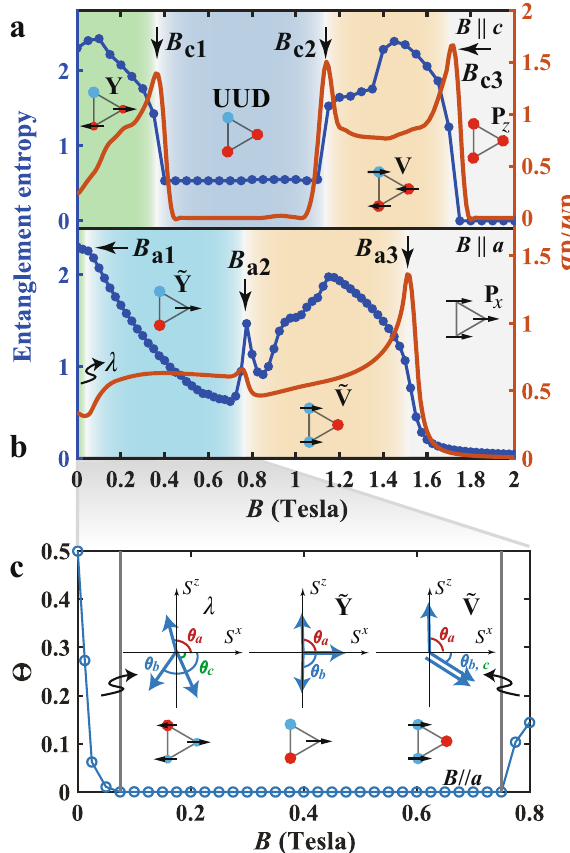
Fig. 3 Zero-temperature phase diagrams under in- and out-of- plane fi elds. a Shows the entanglement entropy and differential magnetic susceptibility dM / dB as functions of fi eld B in the c direction. The Y, UUD, V, and P z phases are shaded in different colors. B c 1, c 2, c 3 are the three critical fi elds separating these phases. The corresponding spin con fi gurations are also shown. Red (blue) circles represent the positive (negative) S z component. Black arrows show the direction of the in-plane ( S x , y ) component. b Is similar to ( a ) but for fi eld B ∥ a . The λ phase, e Y phase, ~ V phase, and P x phase are separated by three critical fi elds B a 1, a 2, a 3 . c Is a zoom-in of ( b ), showing the side view of the spin con fi gurations, as well as the evolution of the order parameter Θ as a function of the fi eld (see main text for de fi are separated by three critical fi elds B a 1 = 0.075 T, B a 2 = 0.75 T, and B a 3 = 1.51 T. The presence of a fi eld ∥ a breaks the U(1)- rotational symmetry with respect to the S z axis but preserves the π -rotational ( Z x axis. The λ phase, 2 ) symmetry with respect to the S where the spins sitting on three magnetic sublattices form the greek letter “ λ ” , spontaneously breaks both the Z 2 symmetry and the lattice translation symmetry. The Z 2 symmetry is restored in the ~ Y phase, and spontaneously broken again in the ~ V phase. Comparing to the fi eld-induced transitions in B ∥ c case, the transitions at B a 1, a 2 show much weaker anomalies in dM / dB when B ∥ a . Numerically, we detect these two transitions using an order parameter Θ ¼ 1 π jð θ a (cid:2) θ b (cid:2) θ c Þj , where θ a , b , c measure the angle between the spin moments on three sublattice and the S x axis. Θ = 0 when the Z 2 symmetry is respected and Θ ≠ 0 when it is broken. Figure 3c shows Θ as a function of fi eld, from which we ~ ~ can delineate the boundaries between λ , Y, and V phases, with the critical fi elds B a 1 ≈ 0.07 T and B a 2 ≈ 0.75 T. The small value of B a 1 implies it could be easily missed in experiments. Meanwhile, the weak anomalies in dM / dB associated with B a 1, a 2 make them